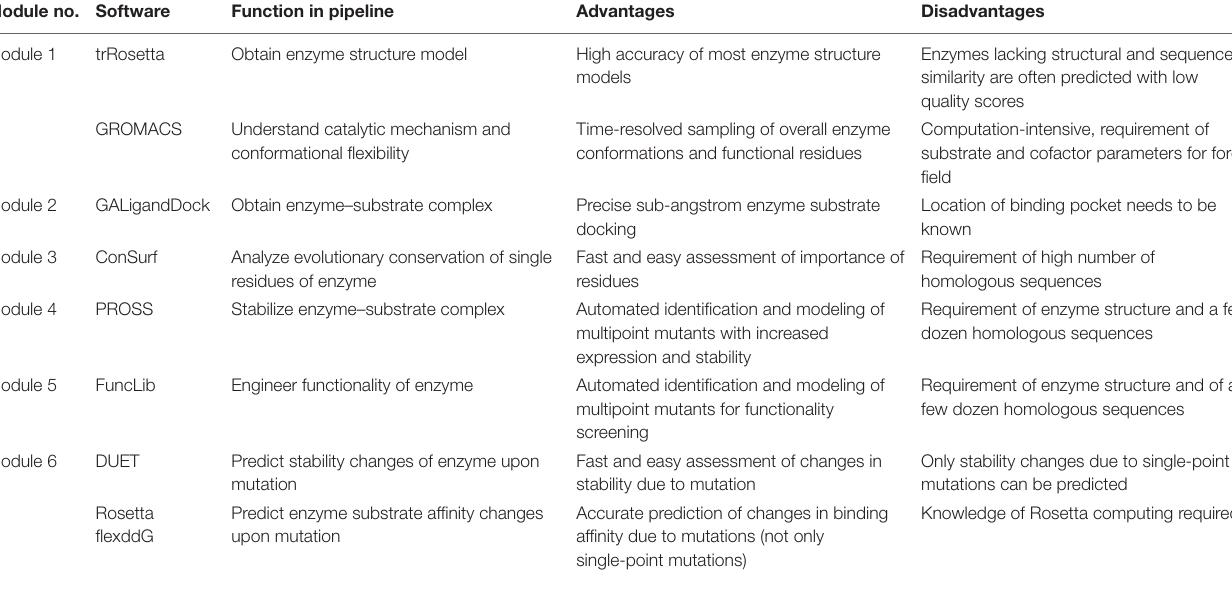
TABLE 2 | Advantages and disadvantages of selected state-of-the-art software and online tools for computational protein engineering. Module no.